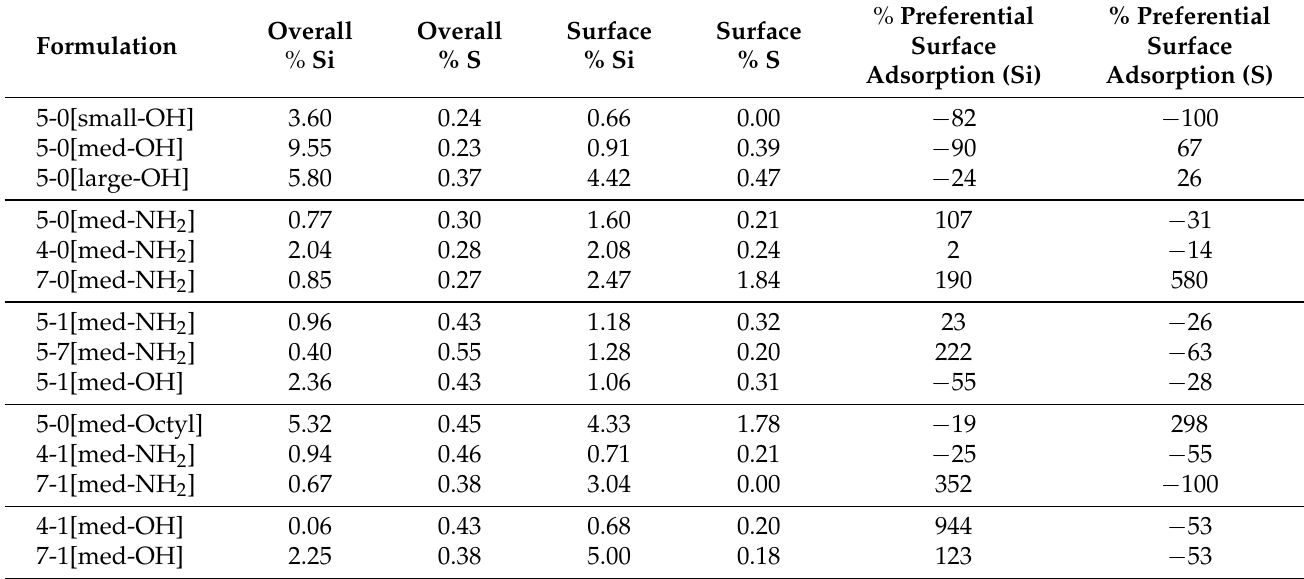
Table 3. Preferential surface adsorption of excipient and protein across all formulations. All percents are in terms of weight. Bulk (overall) elemental compositions were measured via elemental analysis. Surface elemental composition was measured by